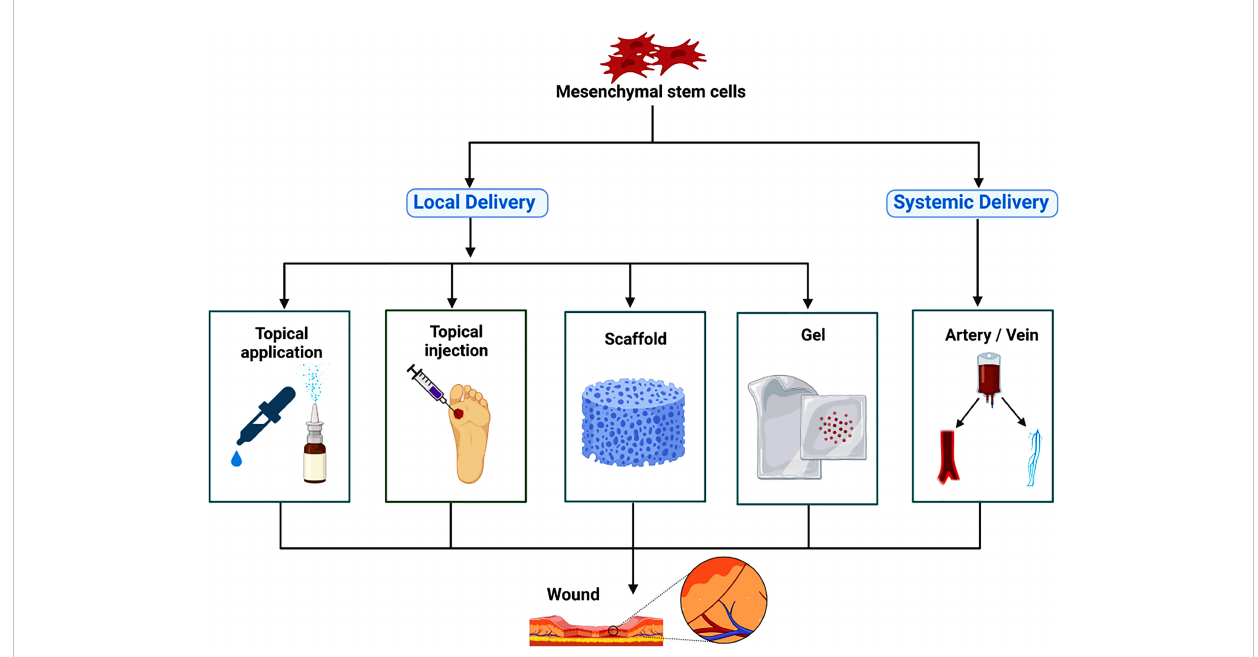
FIGURE 1 The route of administration for mesenchymal stem cells therapy. Mesenchymal stem cells are mainly used for the treatment of diabetic foot by local delivery and systemic delivery. Local delivery is divided into topical application, topical injection, scaffold, gel and so on; systemic delivery is divided into intravenous administration and arterial